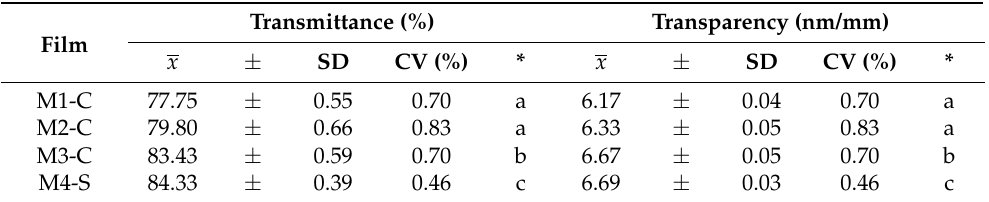
Table 4. Film transparency.